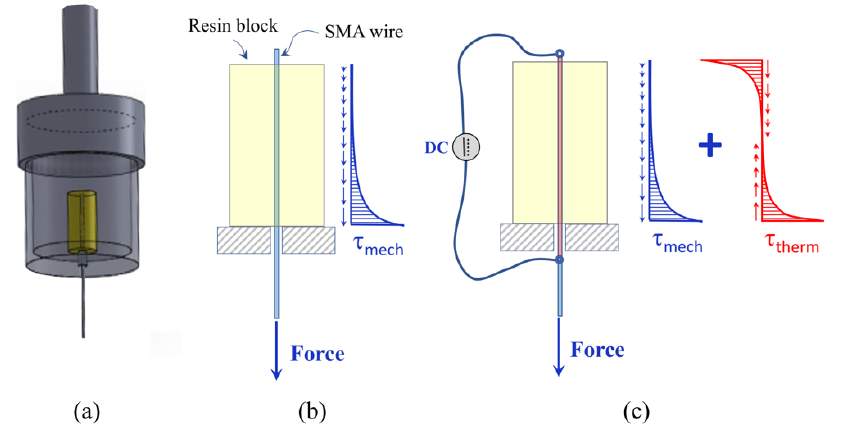
Figure 5. Schematic depiction of pullout tests: ( a ) loading tool, ( b ) mechanical loading (Load case #1) and ( c ) combined application of mechanical loading and thermal activation (Load case #2).